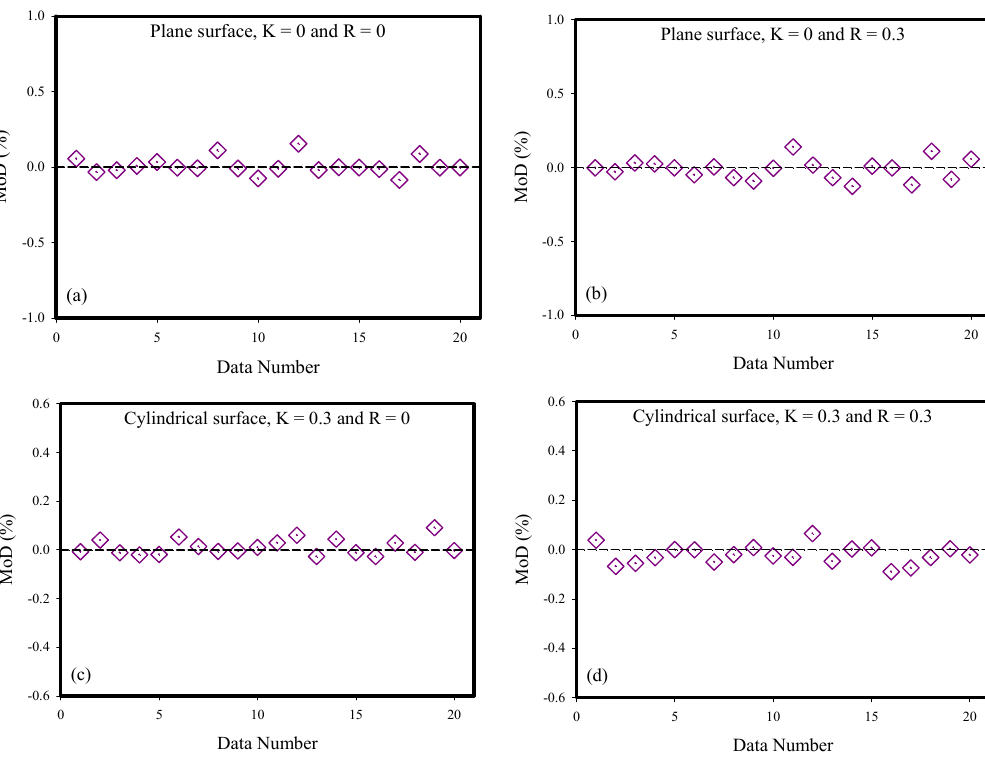
Figure 9. The calculated MoD values of each data used in the development of the ANN model for thermal Flow Regimes-I ( a ), -II ( b ), -III ( c ), and -IV ( d ).